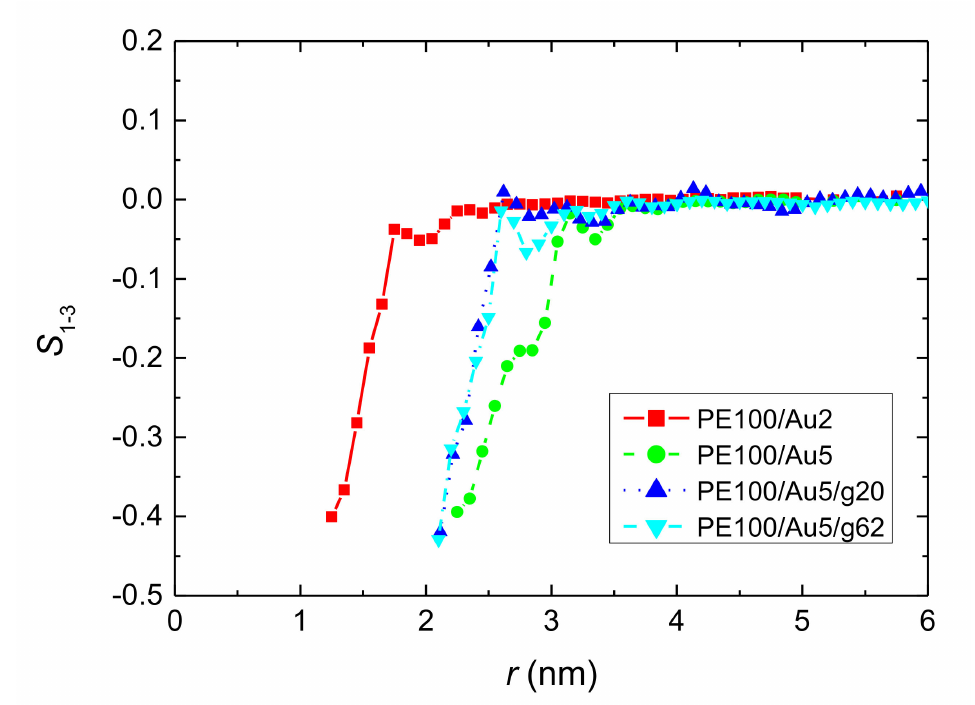
Figure 5. Second rank bond order parameter S 1–3 of polyethylene chains for v 1 − 3 vector, as a function of distance from the center of the Au NP, r , for all PE/Au systems with PE matrices consisting of 100 mers per